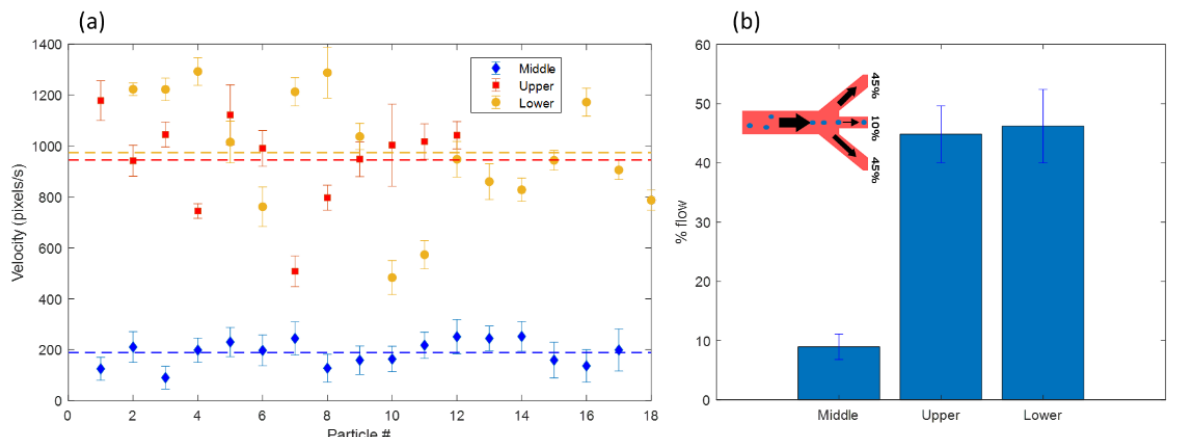
Figure 11. ( a ) Velocity of particles in the three outlets as calculated by ImageJ. The dotted lines indicate the average values for each outlet. ( b ) Percentage of the total flow entering each of the three outlets. The inlet shows the theoretically expected distribution.